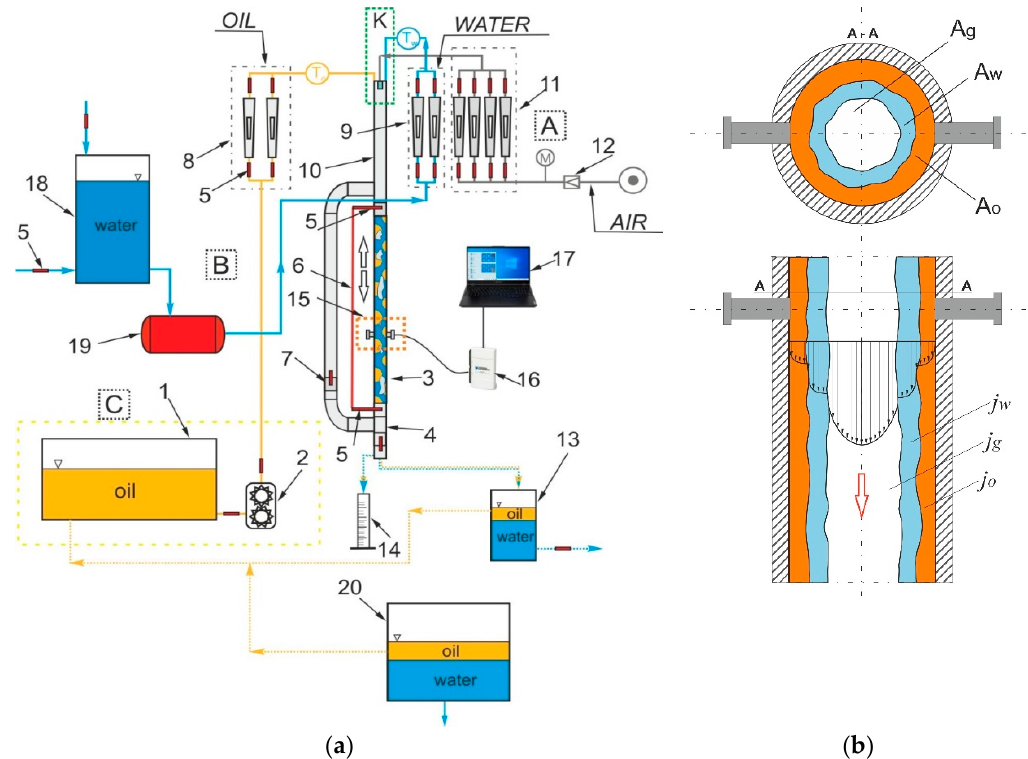
Figure 1. Experimental setup ( a ), cross-section of the test channel ( b ); 1—oil tank, 2—gear pump, 3 and 4—transparent experimental section of channel applied for flow pattern observation and registration, 5—shut-off valves, 6—shut-off gear, 7—ball valve, 8—battery of oil rotameters, 9—battery of water rotameters, 10—non-transparent section of channel, 11—battery of air rotameters, 12—reducing valve, 13 and 20—separators, 14—measuring cylinder, 15—measuring probes, 16—measurement card, 17—computer applied for data registration, 18—oil tank, 19—hydrophor. Feeding systems: C—oil, B—water, A—air, K—chamber for multi-phase mixture generation.